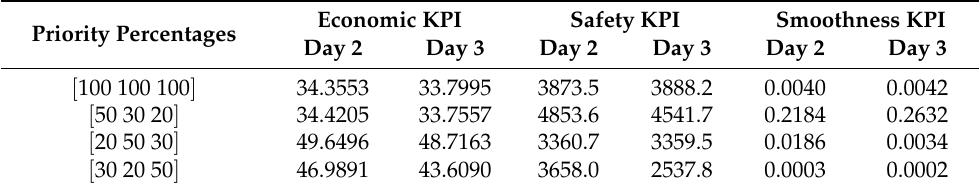
Table 3. KPIs for the DM Strategy (with condition (22)) using the ENNCP Method.